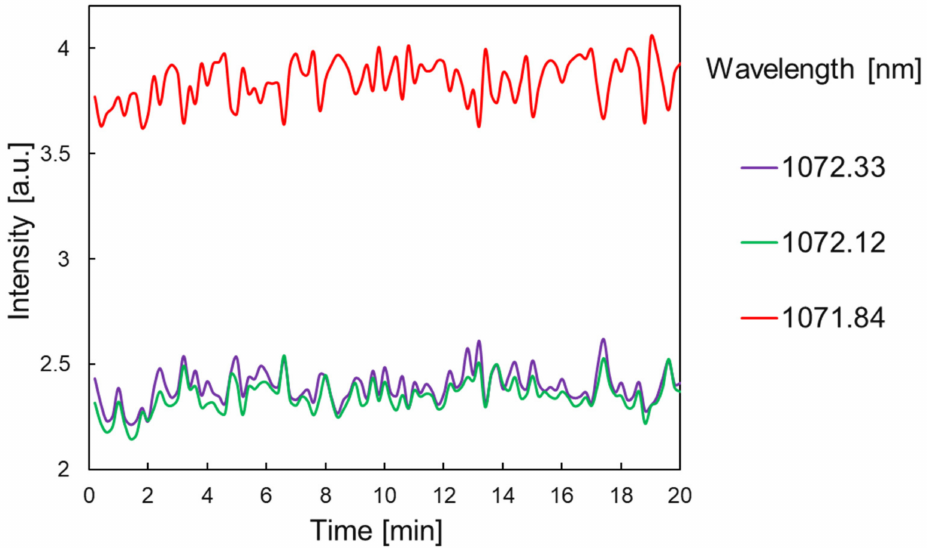
Figure 4. Stability graph of three-wavelength generation without four-wave mixing. The red line with the strongest intensity (1071.84 nm) and the intensities of the other two wavelengths are inversely